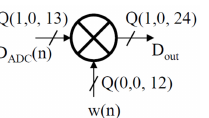
Figure 15. Realization of a FIFO memory using